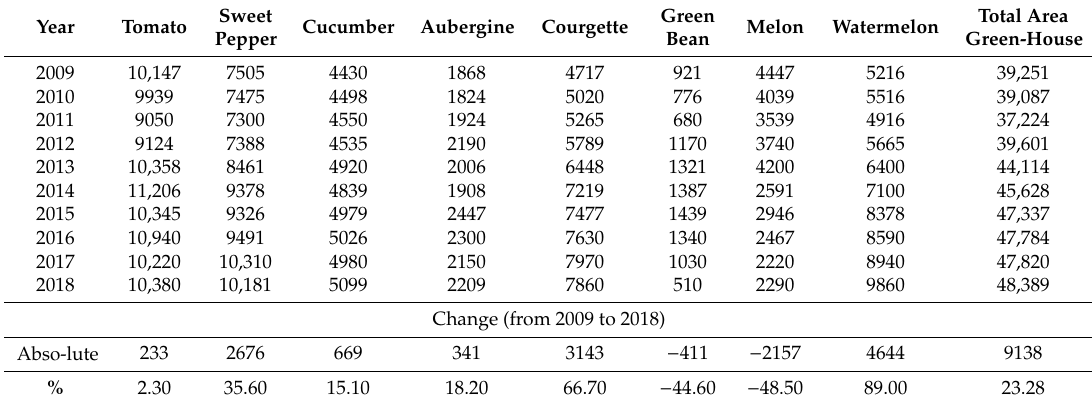
Table 1. Evolution of the wintering area by type of crop (2009–2018) in hectares. Sweet Cucumber Pepper